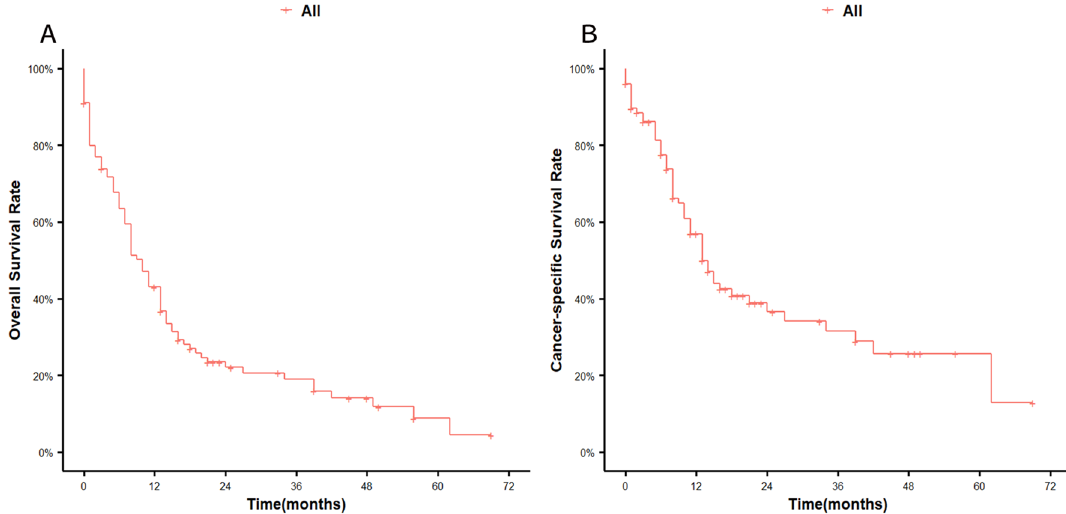
Figure 1. ( A ) Overall survival in elderly NPC, ( B ) cancer-specific survival in elderly